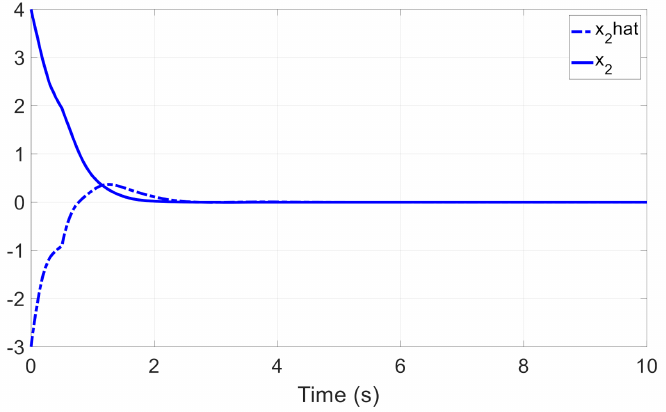
Figure 9. State trajectory of x 2 and state estimation trajectory ˆ x 2 .